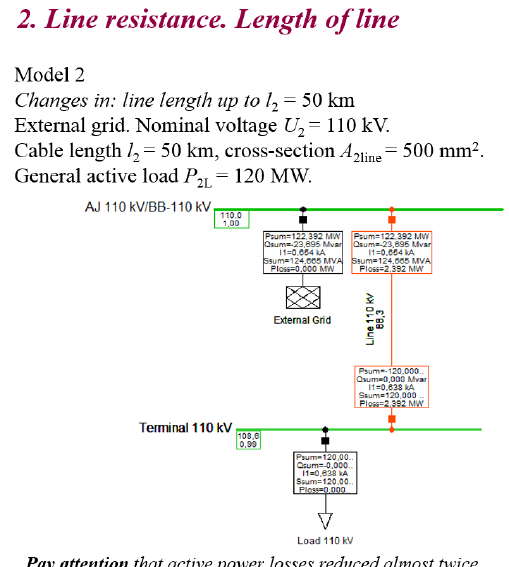
Fig. 2. A part of a slide with the model in PFS for the explanation of line resistance.